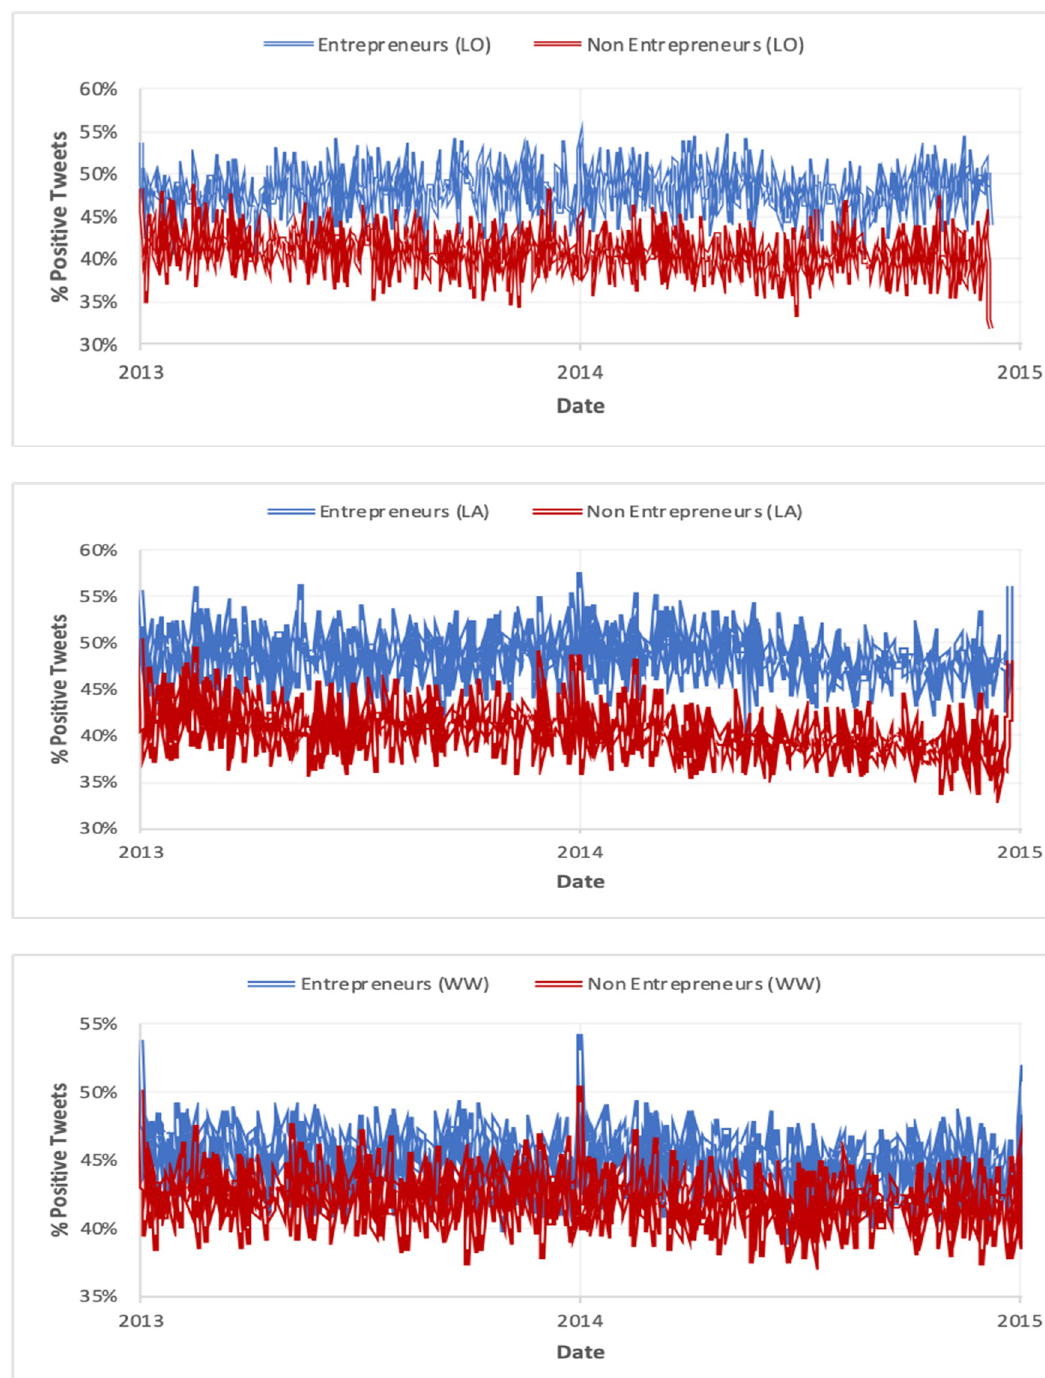
Fig 3. Tweet emotional comparison per calendar day between entrepreneurs and non-entrepreneurs for London (top), Los Angeles (middle) and worldwide (tweet level).